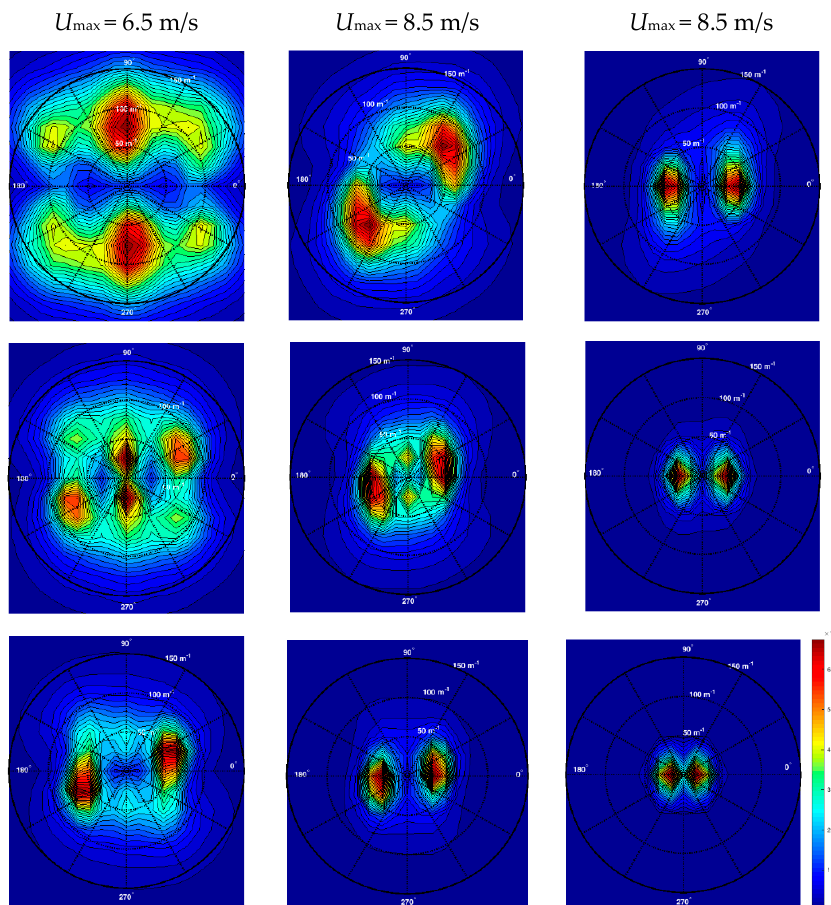
Figure 16. Directional spectra obtained from stereo video reconstruction; upper row: x = 120 cm; middle row: x = 220 cm; bottom row: x = 340 cm. Color bar scale in m 4 .